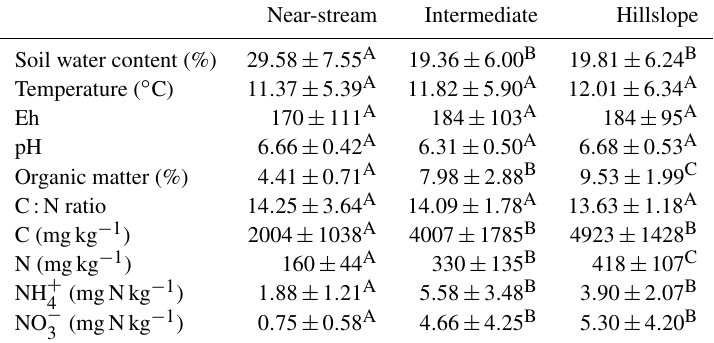
Table 1. Mean annual values ( ± SD) of soil water content (volumetric), soil temperature, soil pH, soil redox capacity (Eh), soil organic matter, soil molar C:N ratio, soil carbon (C) and nitrogen (N) content, and soil ammonium (NH + the three riparian zones. For each variable, different letters indicate statistical significant differences between riparian zones (post hoc Tukey HSD test, p < 0 . 05).